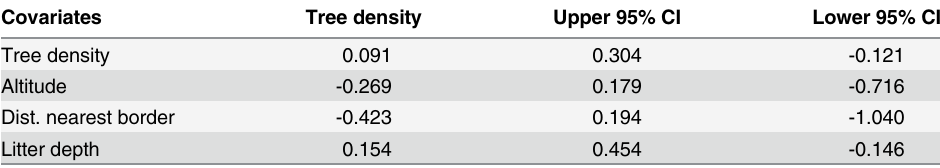
Table 6. Averaged Beta values and upper and lower 95% confidence intervals for occupancy covariates.